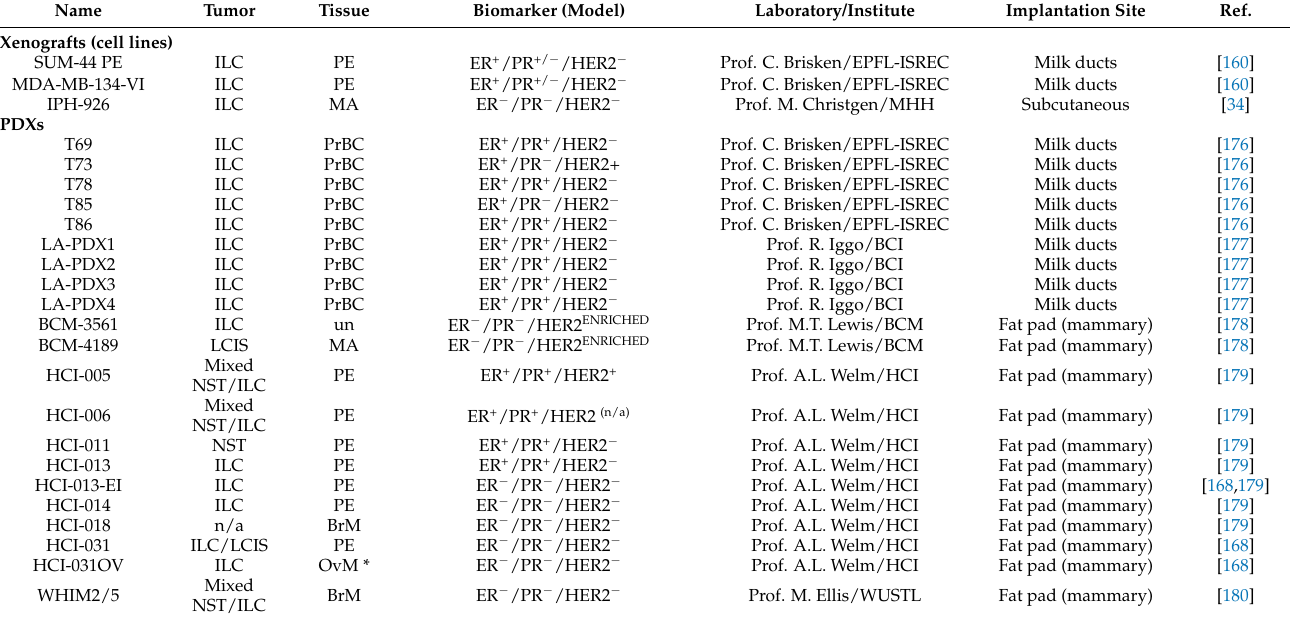
Table 5. ILC Cell Line-Derived and Patient-Derived Xenografts. Abbreviations: MA, malignant ascites; OvM, ovarian metastases (*murine); BrM, brain metastases; ER, estrogen receptor; PR; progesterone receptor; ChR, chest recurrence; NST, non-special type; SkR, Skin recurrence (chest wall); PrBC, primary breast cancer; PE, pleural effusion; LCIS; lob- ular carcinoma in situ; n/a, not available; un: unspecified; SkC, skin right clavicle; AF, Ascitic fluid; EPFL, The É